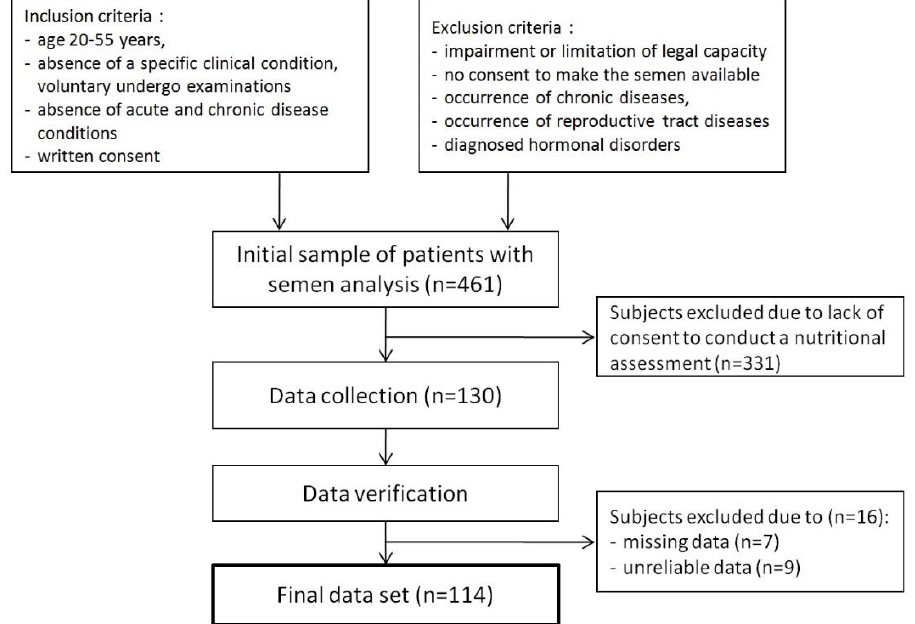
Figure 1. Flow chart of the study population.